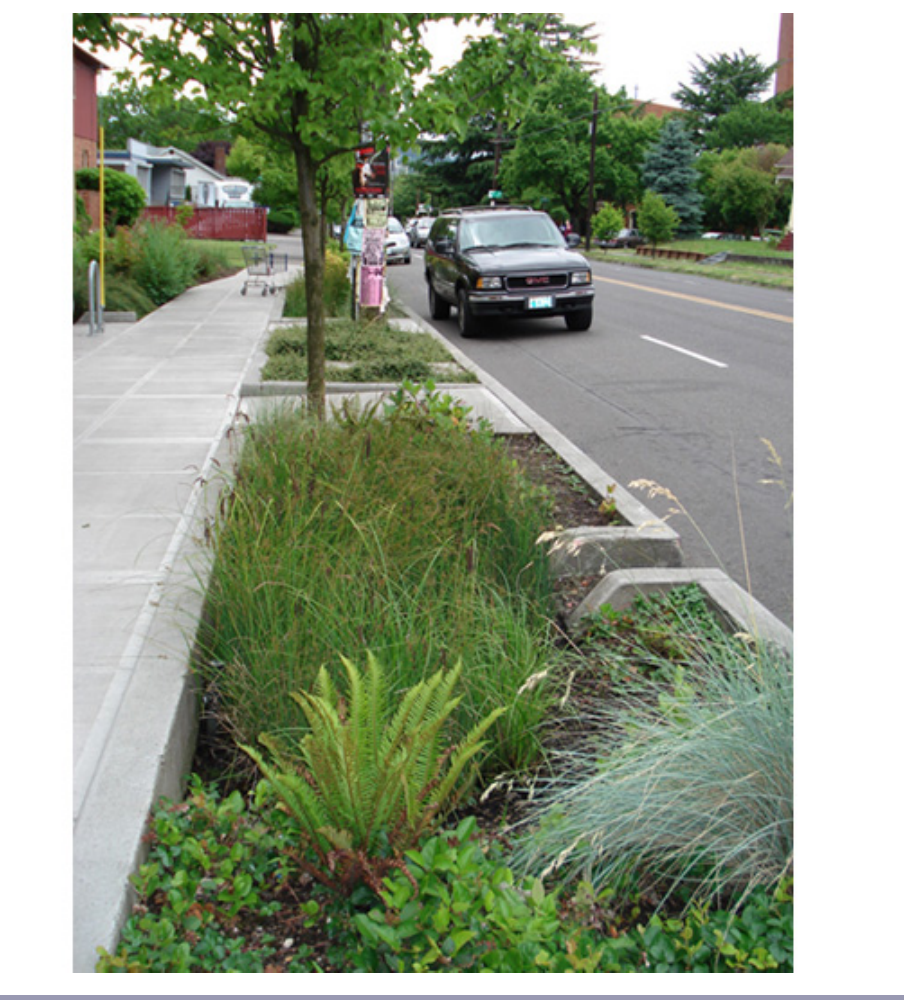
Figure 6. Raingardens developed between streets and sidewalks infiltrate stormwater from these impervious surfaces, while also supporting diversity in